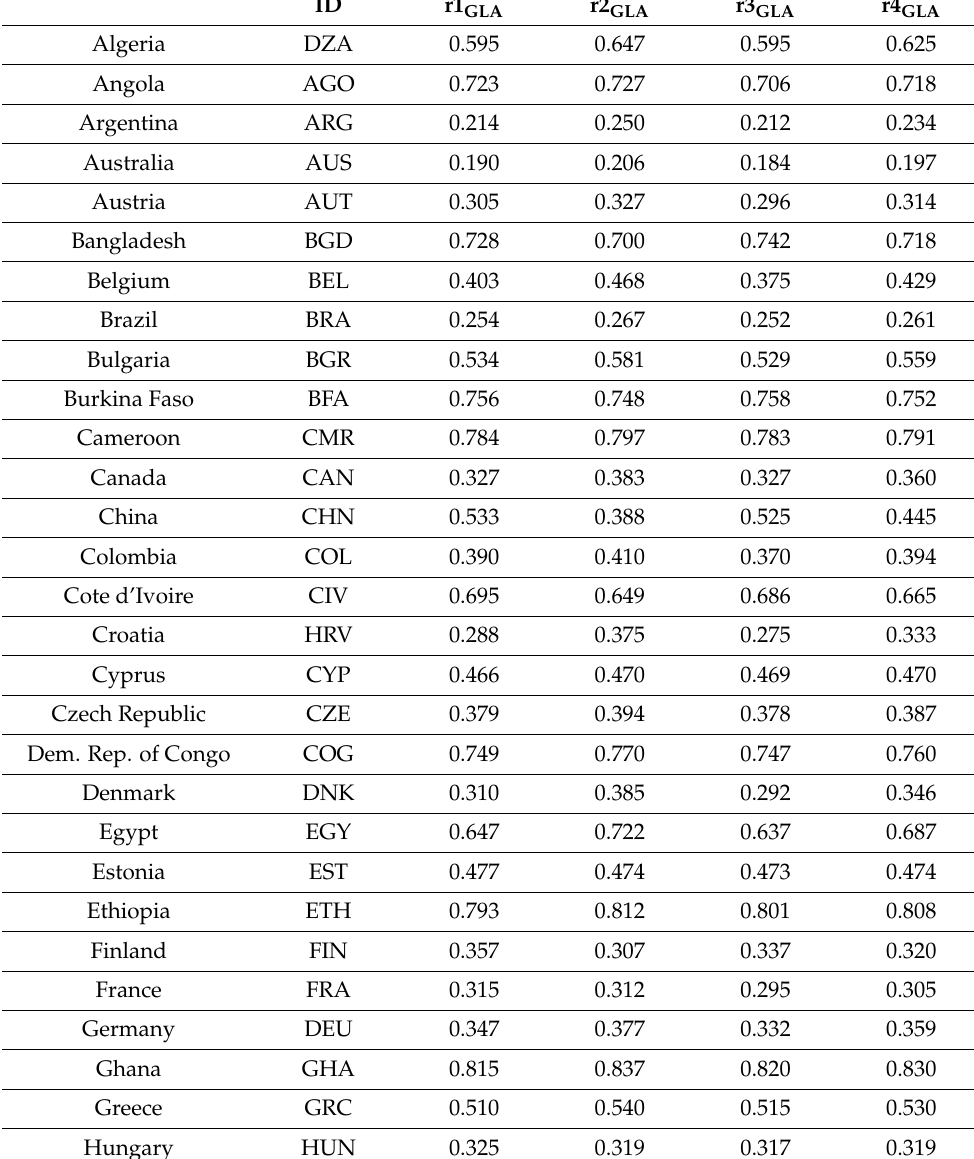
Table 13. The resulting new MIS following